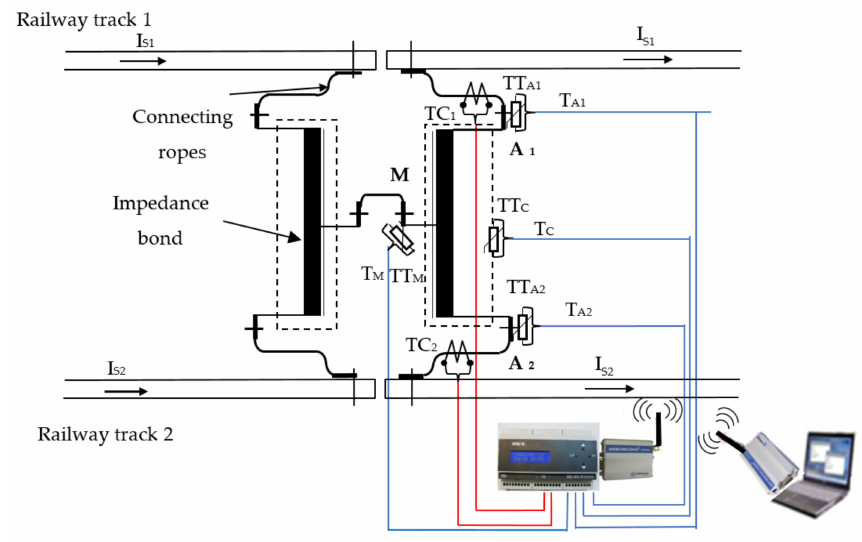
Figure 9. Field monitoring wiring diagram of return